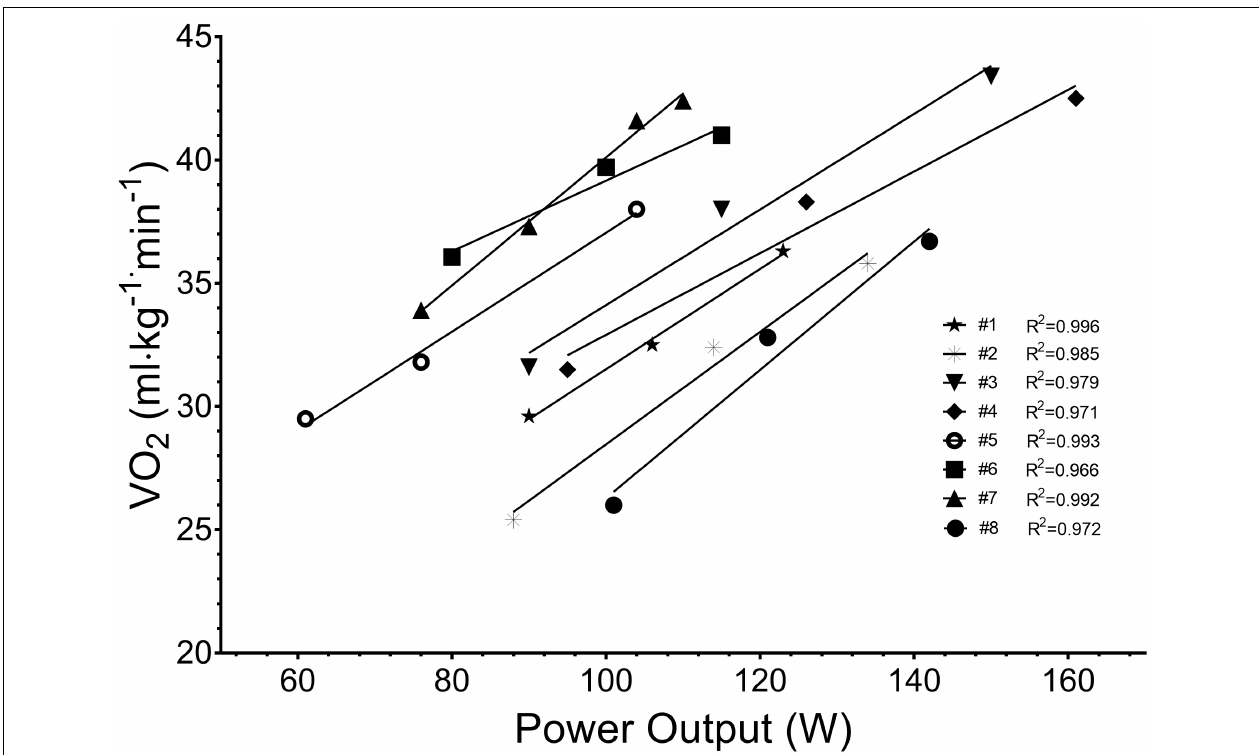
FIGURE 2 | Submaximal field test data for each participant used to determine paddler economy and power: ˙ VO 2 relationship.